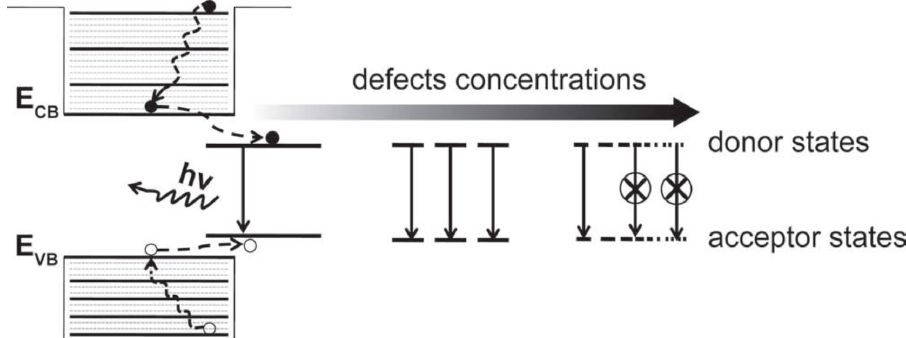
Figure 9. A schematic diagram used to demonstrate the photoluminescence (PL) properties of CuInS 2 NCs [92].